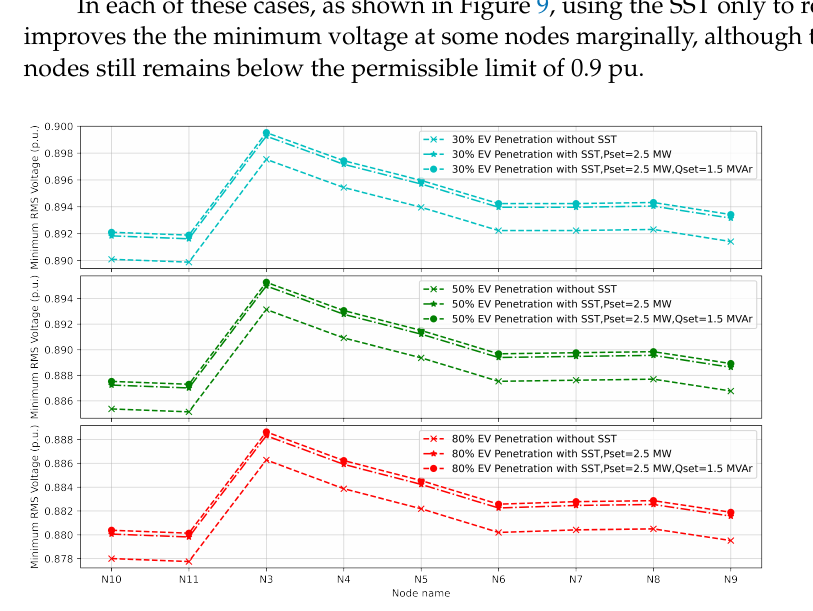
Figure 9. Comparison of minimum RMS voltages with and without